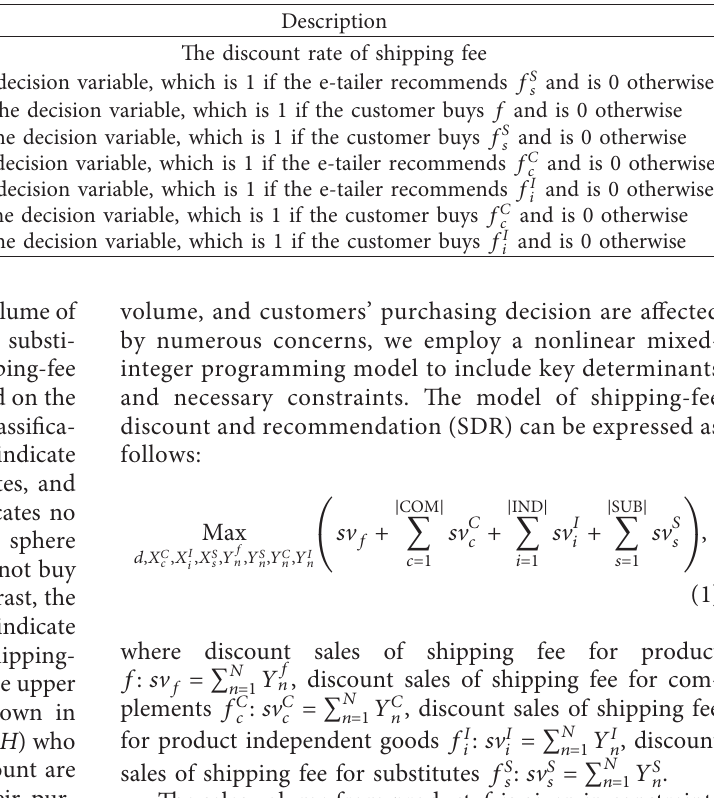
Table 2: Decision